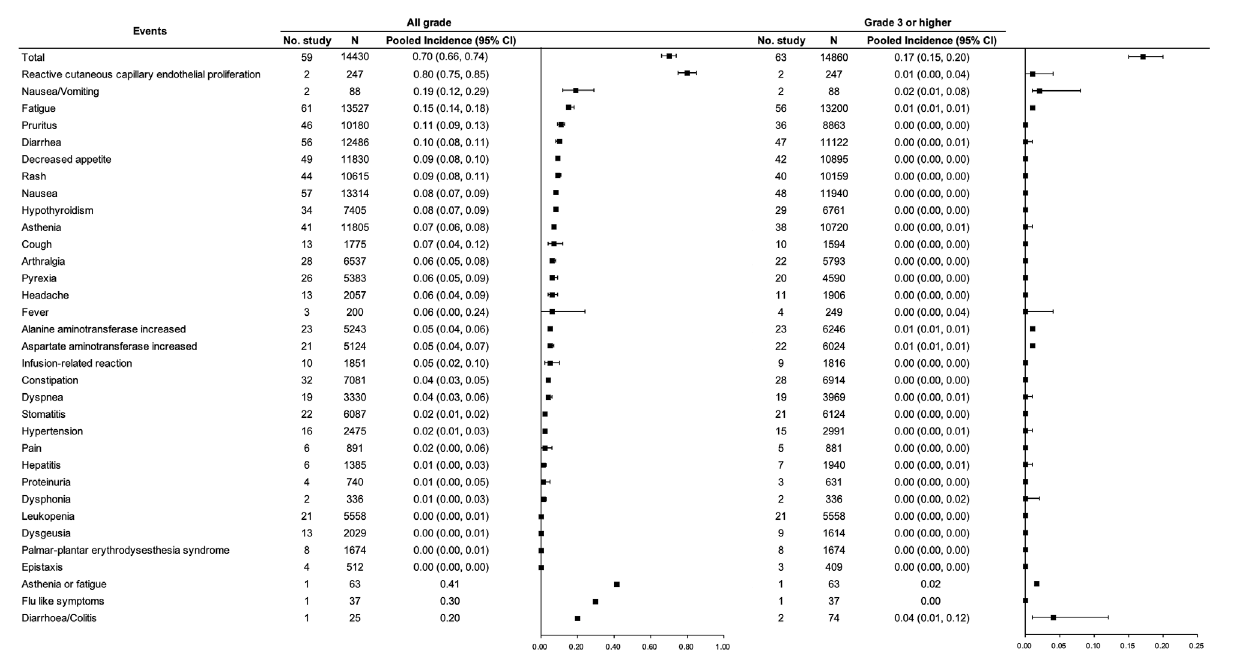
FIGURE 5 Incidence of trAEs for PD-(L)1 inhibitor monotherapy. Note: an incidence of 0.00 indicates a rate < 0.005.